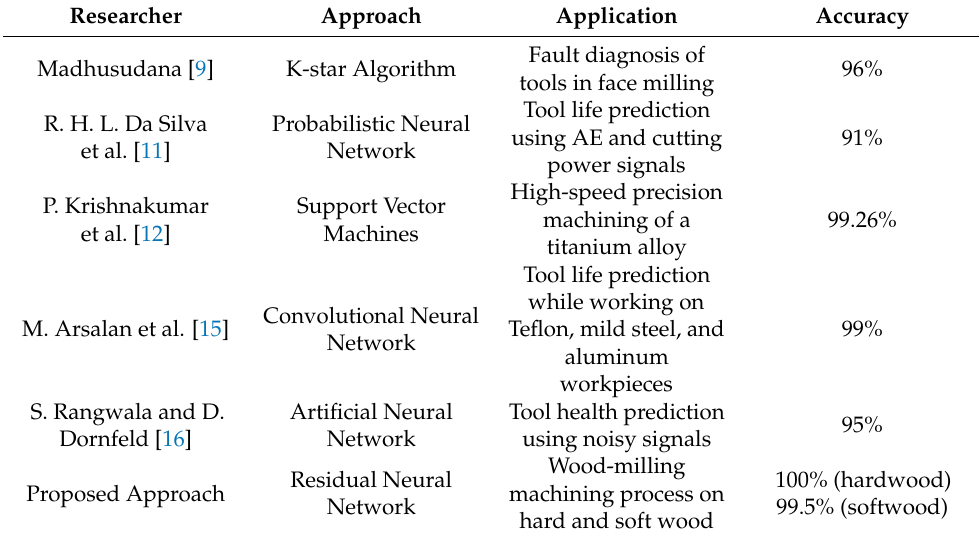
Table 1. Comparison of the proposed approach with previously carried out